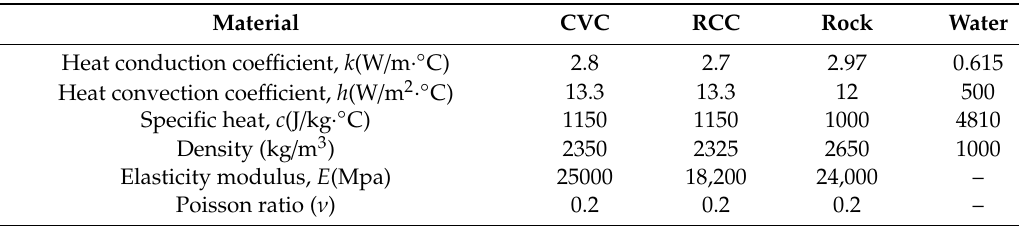
Table 1. Thermal and structural material